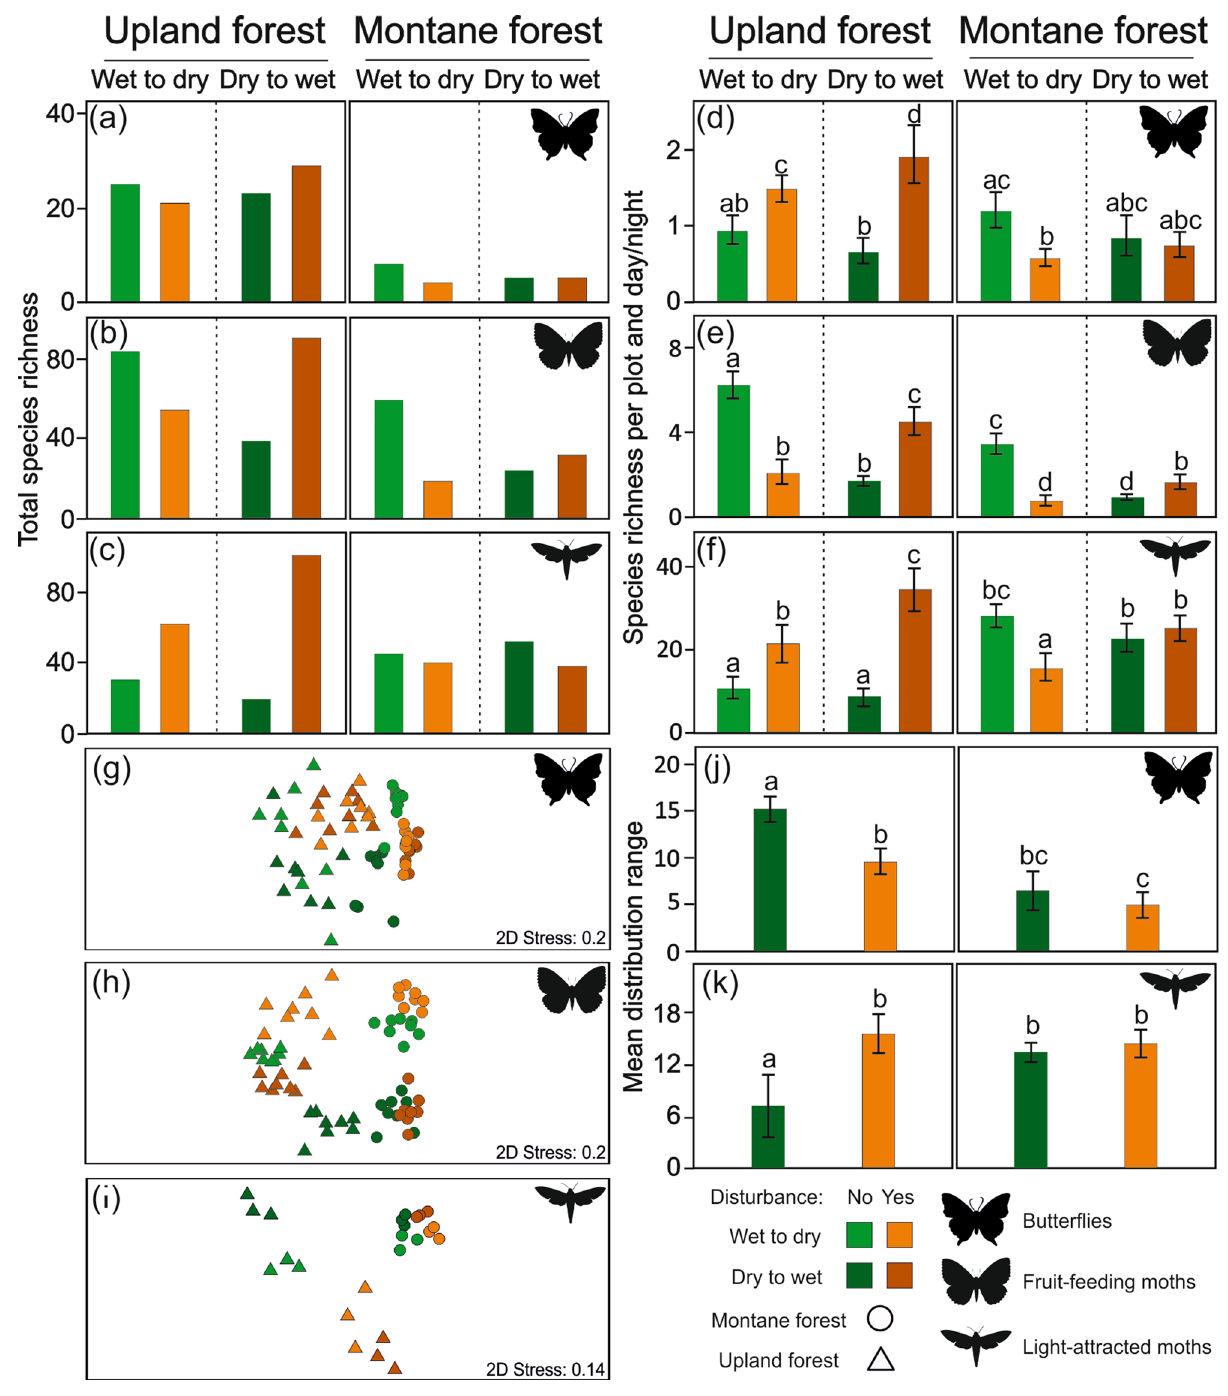
Figure 3. Species richness of insects per sampling site and season ( a – c ), and sampling plots and day or night ( d – f ) as estimated by GEEs (estimated means with 95% unconditional confidence intervals are visualized). ( g – i ) NMDS diagrams of insect community compositions at the sampled forest plots. ( j , k ) Mean distribution range of insects estimated by GEEs. Letters visualize results of the post-hoc pairwise